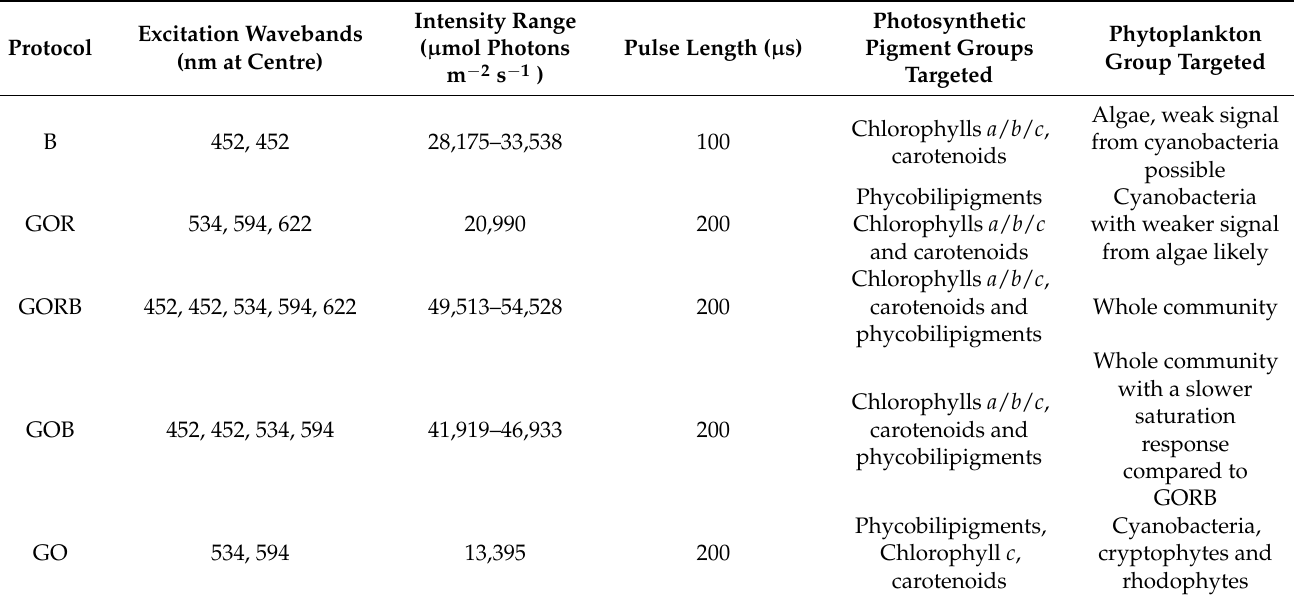
Table 1. Excitation protocols tested to target pigments associated with specific phytoplankton groups, as described by [40,41]. Phycobilipigments include phycoerythrin, allophycocyanin and